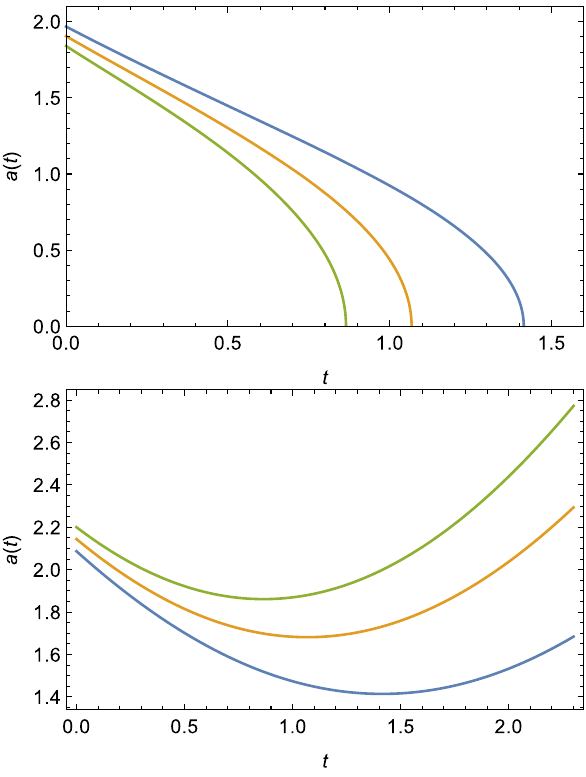
Fig. 5 Evolution of the two-sphere for p = 1 √ graph on top, a 0 > 0 (the blue curve is for a 0 = 1, the yellow curve is for a 0 = 2 and the green curve is for a 0 = 3). For the graph on bottom, a 0 < 0 (the blue curve is for a 0 = − 1, the yellow curve is for a 0 = − 2 and the green curve is for a 0 = −